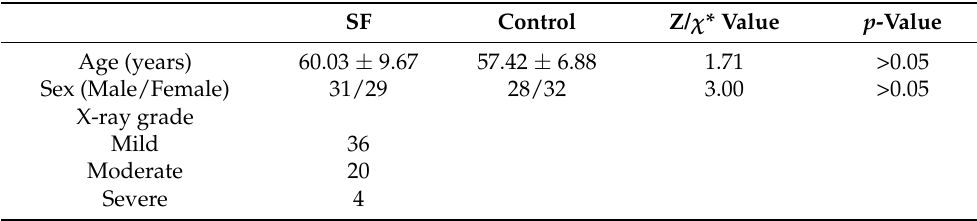
Table 1. Demographic